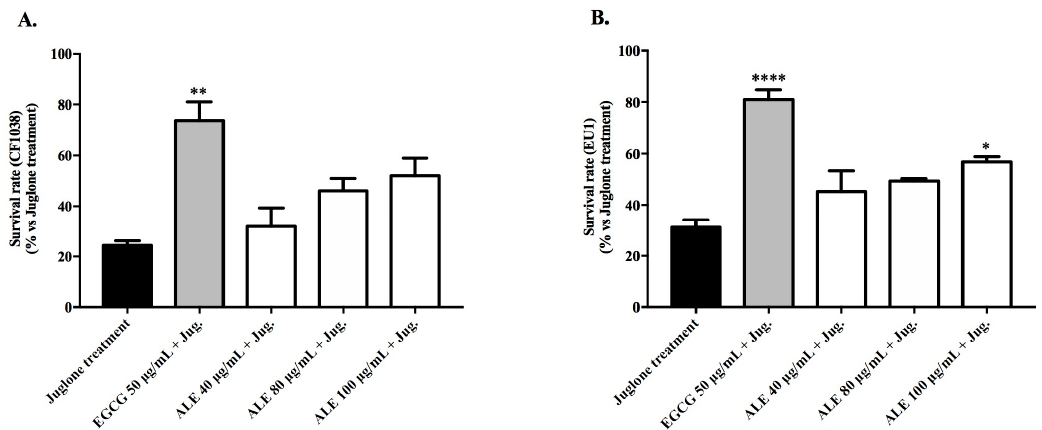
Figure 6. Survival rates of juglone-stressed (80 µM) C. elegans mutant strains pre-treated with 40–100 µg/mL of extract ALE from Uncaria tomentosa, showing the following: ( A ) mutant worms lacking daf-16 (CF1038) and ( B ) mutant strains lacking skn- 1 (EU1). The control groups were the juglone-treated worms or juglone-stressed worms pre-treated with EGCG at 50 µg/mL. Each bar represents the mean value ± SEM from three independent assays. The asterisks indicate the statistical differences in relation to the juglone-treated worms according to one-way ANOVA followed by a post-hoc Tukey’s test: * p < 0.05, ** p < 0.01, and **** p < 0.0001.